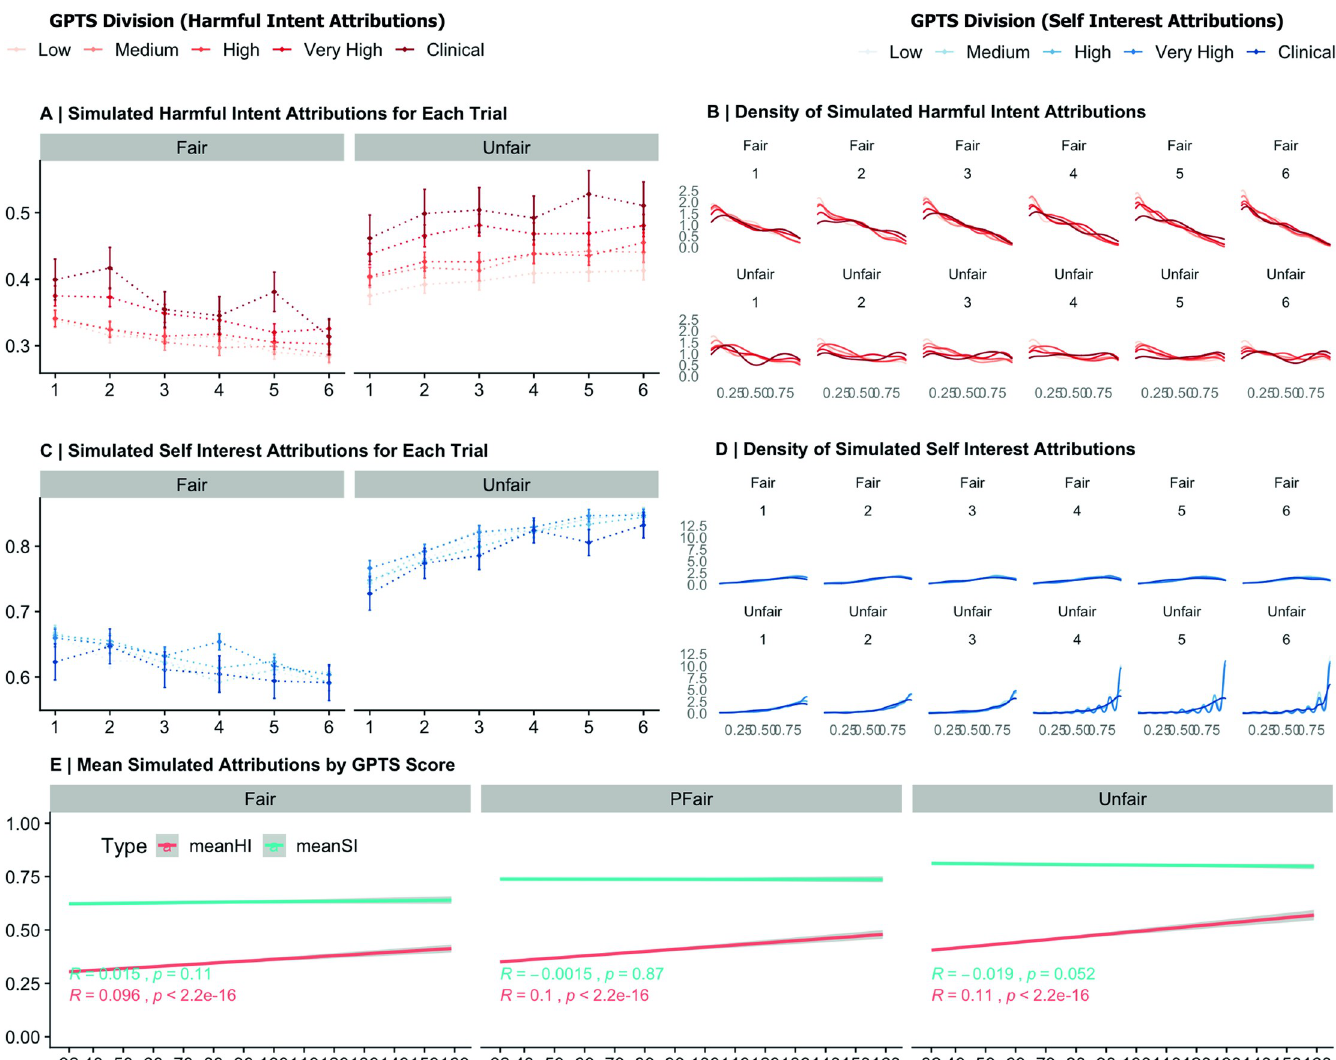
Fig 2. Simulated Behavioural Data. (A) Generated Harmful Intent (HI) attributions for simulated participants at each level of paranoia at each trial within fair and unfair dictators. Dots represent the mean for each level of paranoia. Lines represent the 95% confidence interval. (B) Generated density distributions for simulated participant HI attributions (red) for each trial (1–6) within unfair and fair dictators for each level of paranoia. (C) Generated Self-Interest (SI) attributions for simulated participants at each level of paranoia at each trial within fair and unfair dictators. Dots represent the mean for each level of paranoia. Lines represent the 95% confidence interval. (D) Generated density distributions for simulated participant SI attributions (blue) for each trial (1–6) within unfair and fair dictators for each level of paranoia. (E) Smoothed linear splines for both simulated participant harmful intent and self-interest attributions by prior paranoia (minimum score = 32).